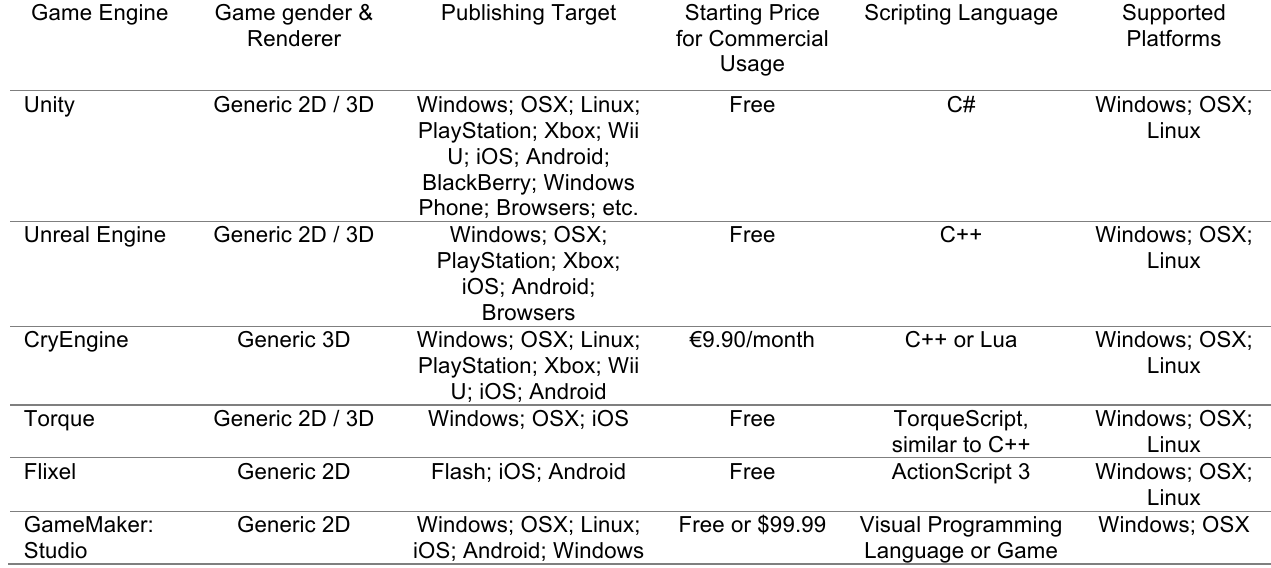
Table 1. Summary of game engine